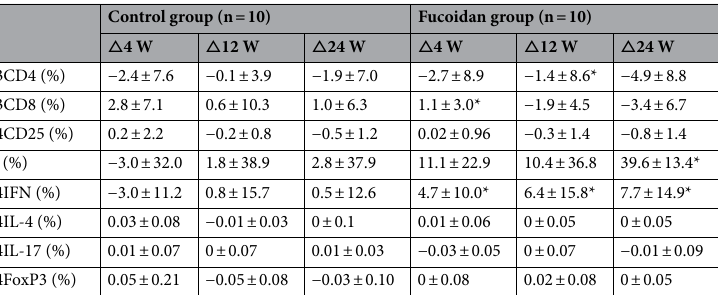
Table 4. The changed proportion of immune cell types in the two groups during supplementation period. △ : Indicates the data of week 4 or 12 or 24 minus the data of week 0. *: Indicates the data subtracted from the 4th week or the 12th week or the 24th week and the 0th week, there is a significant difference between the control group and the fucoidan group (p <